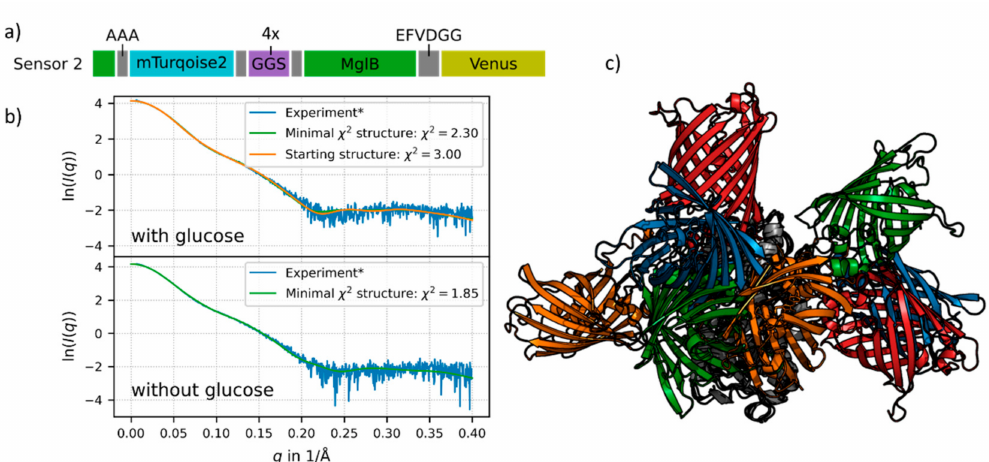
Figure 3. ( a ) Schematic presentation of the sensor no. 2 sequence. The flexible linker (purple) and restriction sites (grey) are shown with their respective sequences. The donor FP (mTurquoise2, cyan) is inserted into MglB (green), so the first 11 residues of MglB are in the beginning of the sequence and the main part in the middle. The acceptor FP (Venus) is shown in yellow (for details see Supplementary Materials, Section S1). ( b ) The experimental SAXS data is shown in blue, the fit of the chosen starting structure (blue FPs in Figure 3c) in orange, the latter is only shown for the glucose-saturated structure. Structures from the simulations with respective minimal χ 2 values are shown in green. ( c ) Starting structures for the simulation of sensor no. 2 with MglB in the glucose-saturated state. All structures are aligned to MglB (grey). The different pairs of fluorescent proteins are depicted in orange (sensor 2-1, χ 2 = 3.0), blue (sensor 2-2, χ 2 = 3.11), green (sensor 2-3, χ 2 = 3.75) and red (sensor 2-4, χ 2 = 4.1). For details see Supplementary Materials, Section